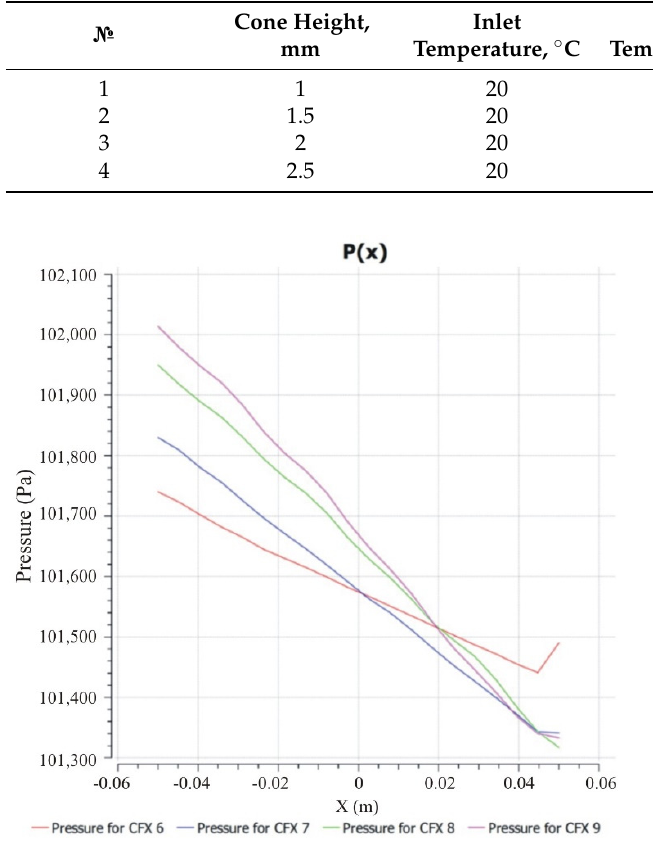
Table 3. Temperature value.